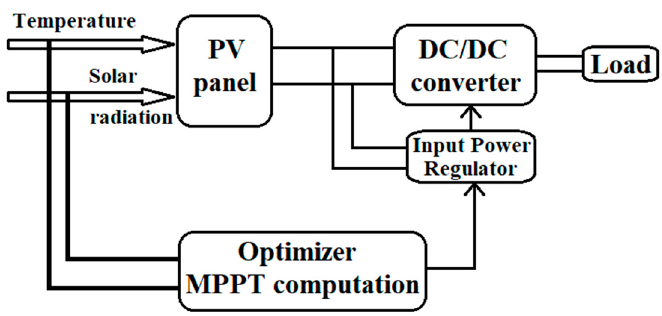
Figure 2. Simplified MPPT architecture.